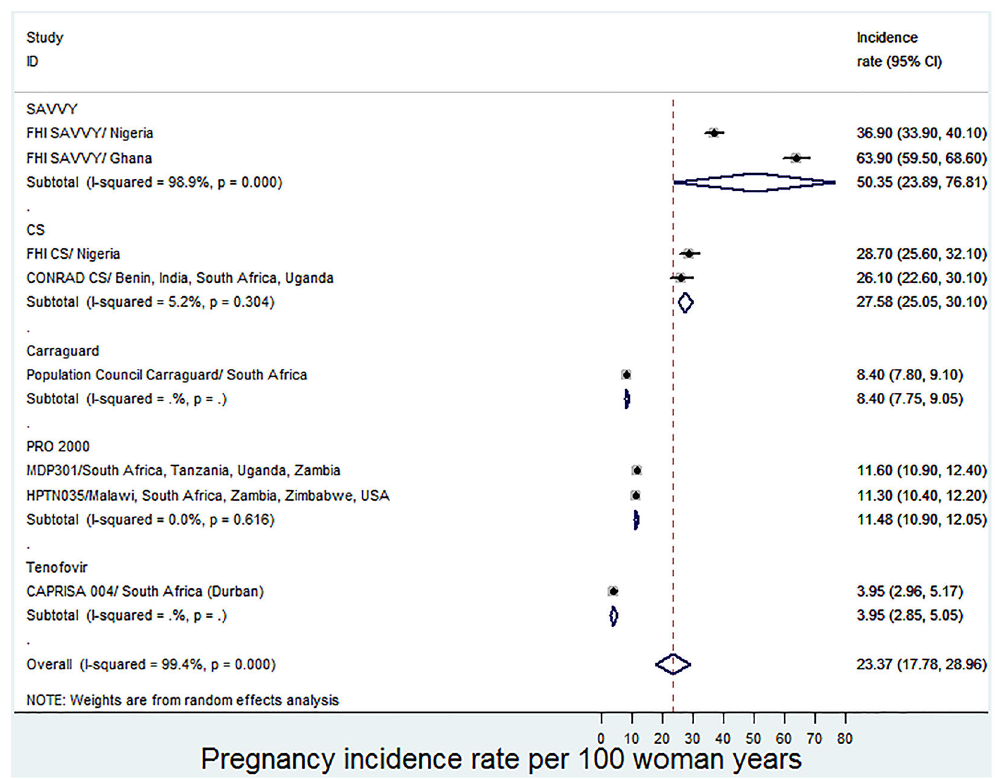
Figure 3. Forest plot for the meta-analysis of incidence rates of pregnancy (per 100 woman-years) in microbicide